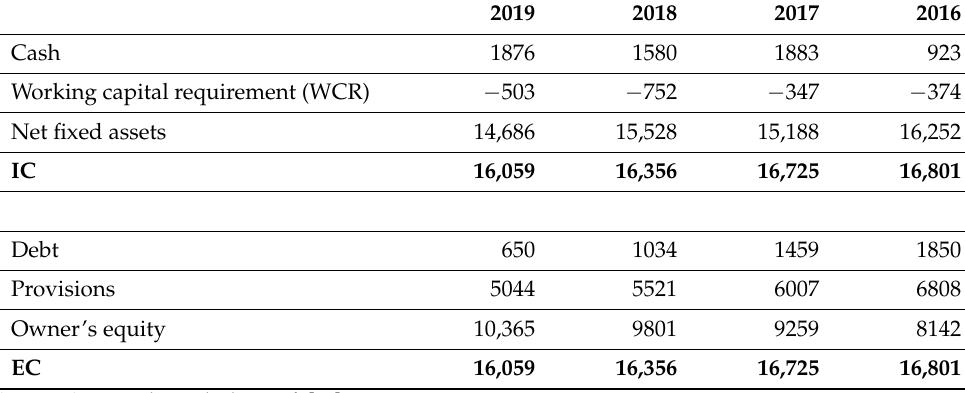
Table 5. Managerial balance sheet of Geotermia Podd˛ebice Sp. z o.o. (PLN